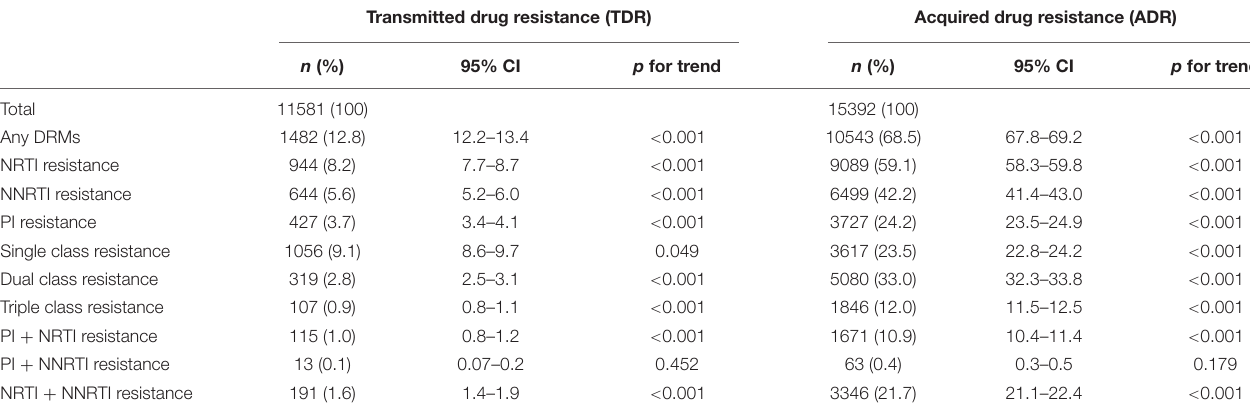
TABLE 2 | Proportion of transmitted drug (TDR) and acquired drug resistance (ADR) between 1991 and 2019. Transmitted drug resistance (TDR)